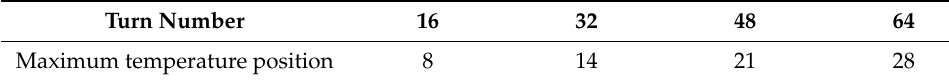
Table 3. The main parameters of electromagnetic field and loss calculation.